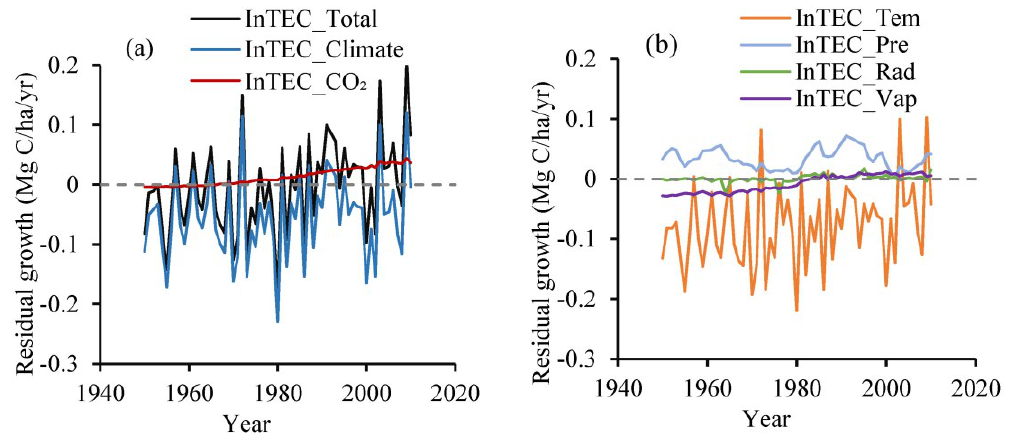
Figure 9. Partition of the growth enhancement into contributions from climate and CO 2 fertilization ( a ), and the climate effect is partitioned to factors of temperature, precipitation, radiation, and water vapor pressure ( b ).